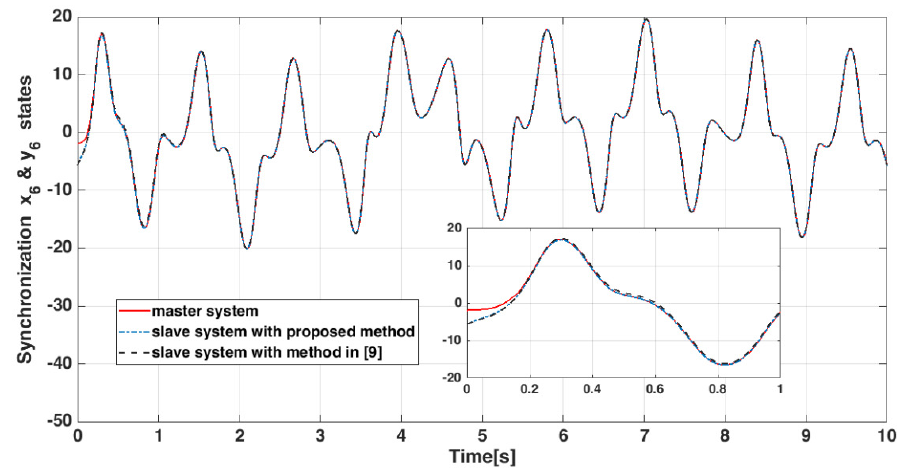
Figure 14. State error 𝒆 𝟏 of master-slave systems